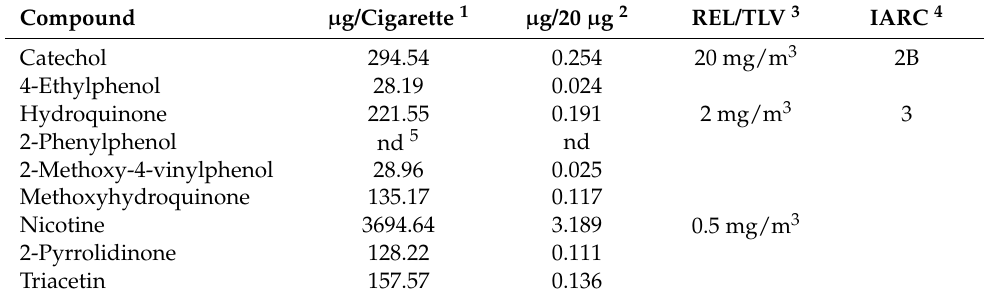
Table 4. Amounts of putative estrogenic components in cigarette sidestream smoke particulate matter.